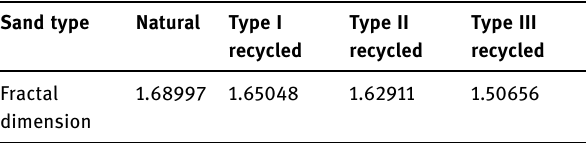
Table 8: Fractal dimension of recycled coarse aggregate